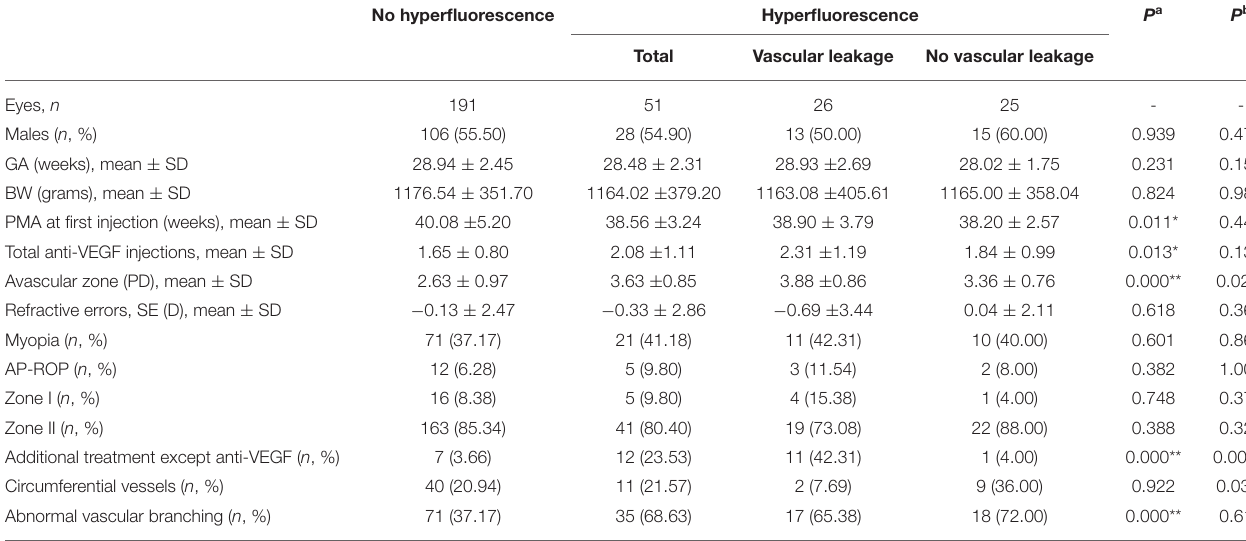
TABLE 2 | Demographic and treatment characteristics for patients with ROP with or without different types of